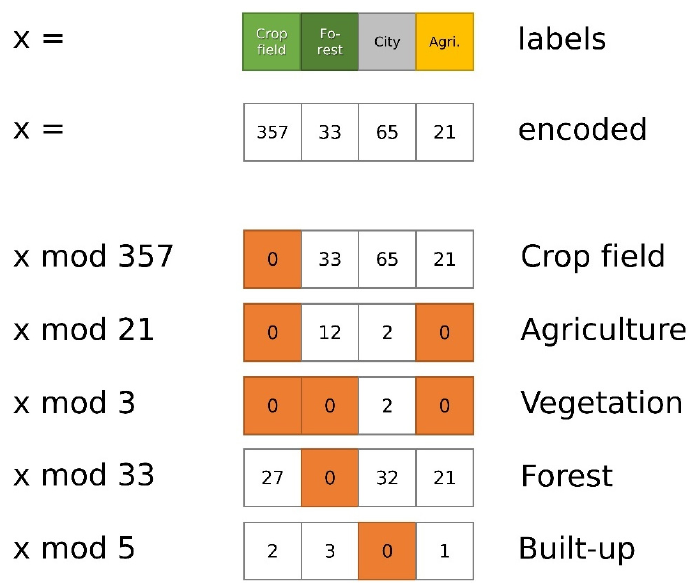
Figure 3. Example encoding and masking in a one-dimensional case. The equation itself can be applied to any n-dimensional array.